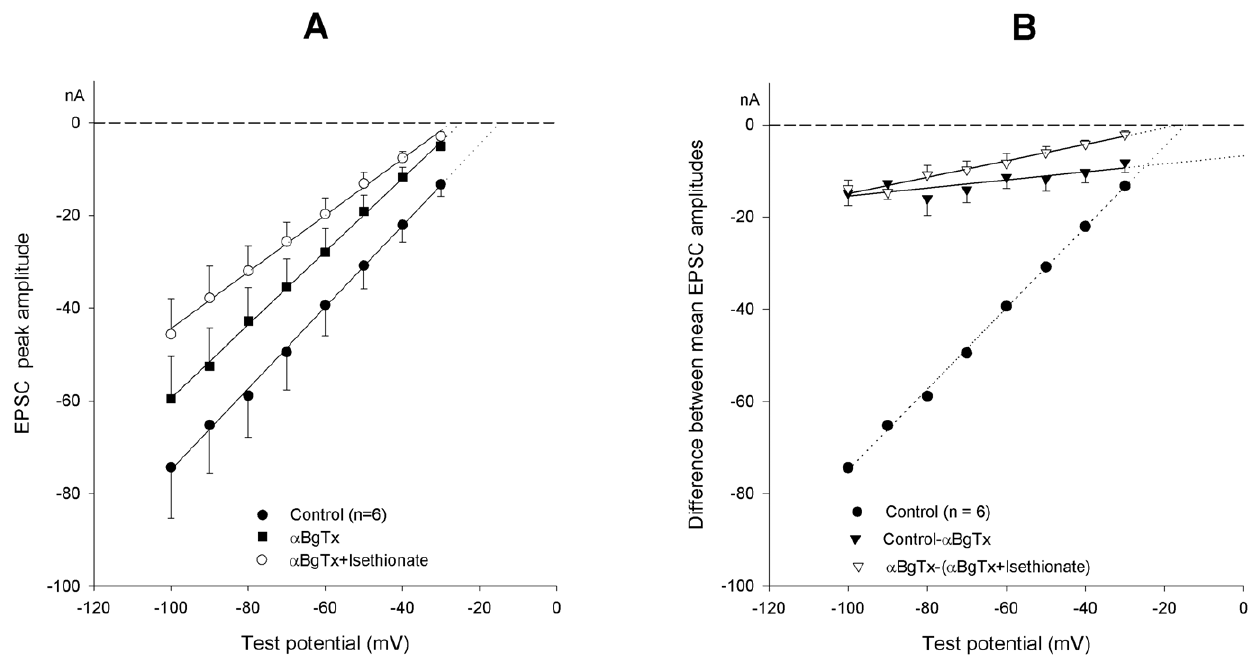
Figure 3. Cumulative effects of a BgTx application and [Cl 2 ] o reduction. ( A ). I–V relationship of EPSC peak amplitude in control (filled circles; P K /P Na ratio =1.52 6 0.11), after 200 nM a BgTx application (squares; P K /P Na ratio =2.22 6 0.13) and after cumulative isethionate replacement (open circles; P K /P Na ratio =2.38 6 0.07), substituting for 136 mM NaCl. Goldman equation curves are fitted to the mean values from the same 6-neuron pool. ( B ). I–V curves of the difference currents showing the effect of a BgTx (filled triangles; note the largely positive equilibrium potential) and of the subsequent application of the low-chloride solution in the presence of the toxin (open triangles). Control values (circles) and the EPSC peak amplitudes generating the difference currents are the same as in ( A ). Zero crossing points of the fits indicate the corresponding E ACh estimates.